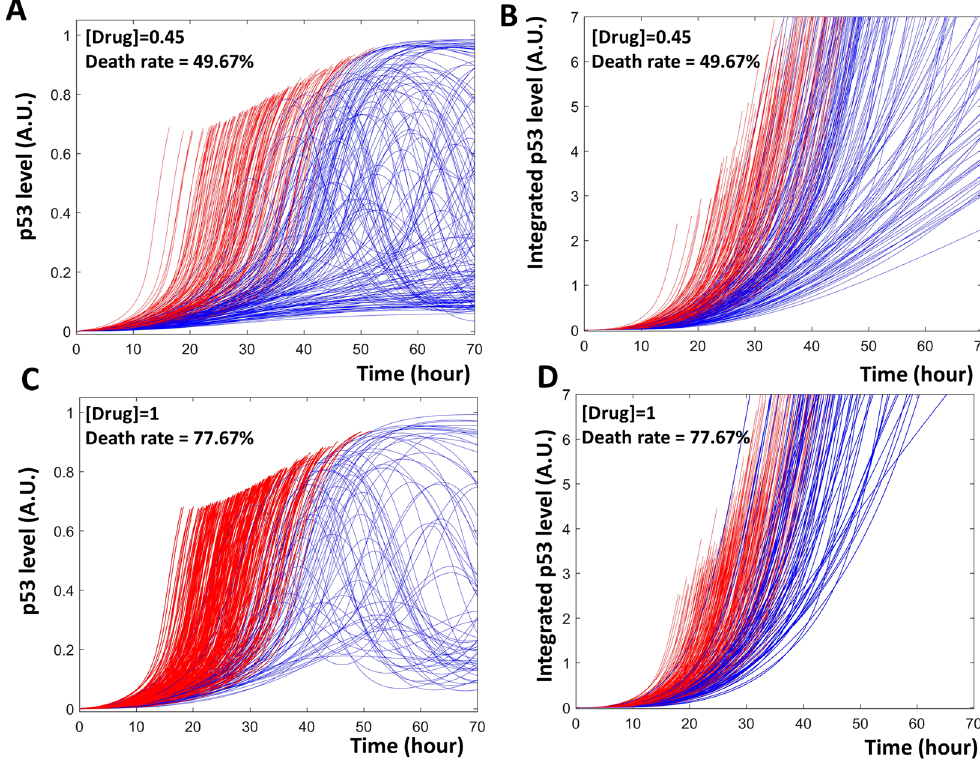
Figure 2. Time series simulation of fractional killing. Panels A and C show the absolute levels of p53, while panels B and D show the time integrated levels. ( A and B ) A total of 300 cells are subjected to a low level of drug (drug = 0.45), about half of the cells in the population quickly activate p53 and undergo apoptosis (red curves in A and B). In the remaining cells, p53 is slowly activated and these cells survive (blue curves in A and B ). ( C and D ) When a population of 300 cells are treated with a high level of drug (drug = 1), a higher percentage of cells activate their p53 fast and undergo apoptosis (red curves in C and D